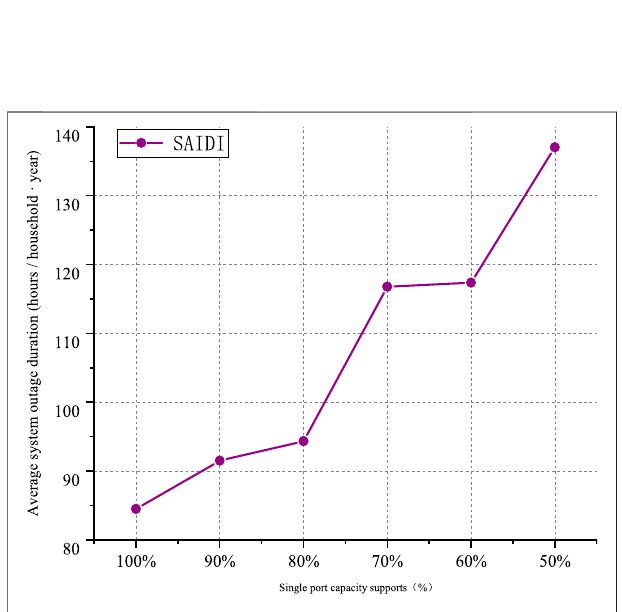
FIGURE 17 | Analysis and comparison of the impact of PET port capacity on